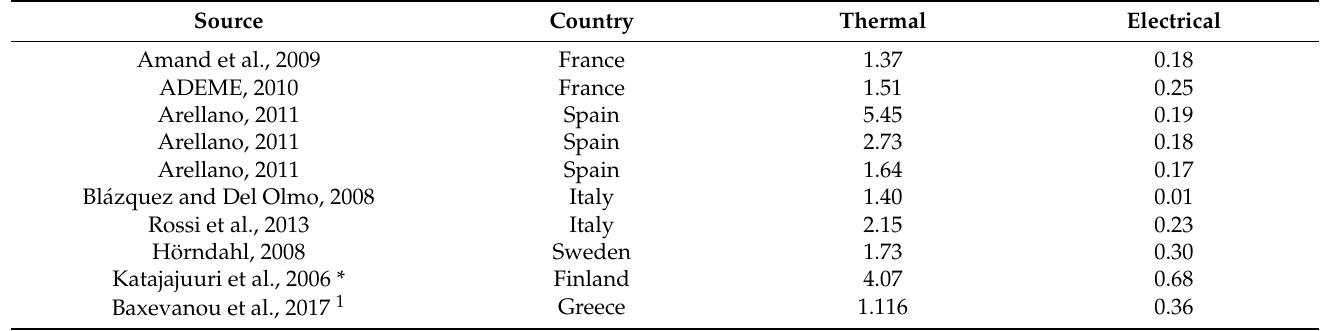
Table 5. Thermal and electrical energy consumption in broiler systems MJ/kg meat (based on [7,55,56]).